Question: Express in one sentence what the figure is showing.
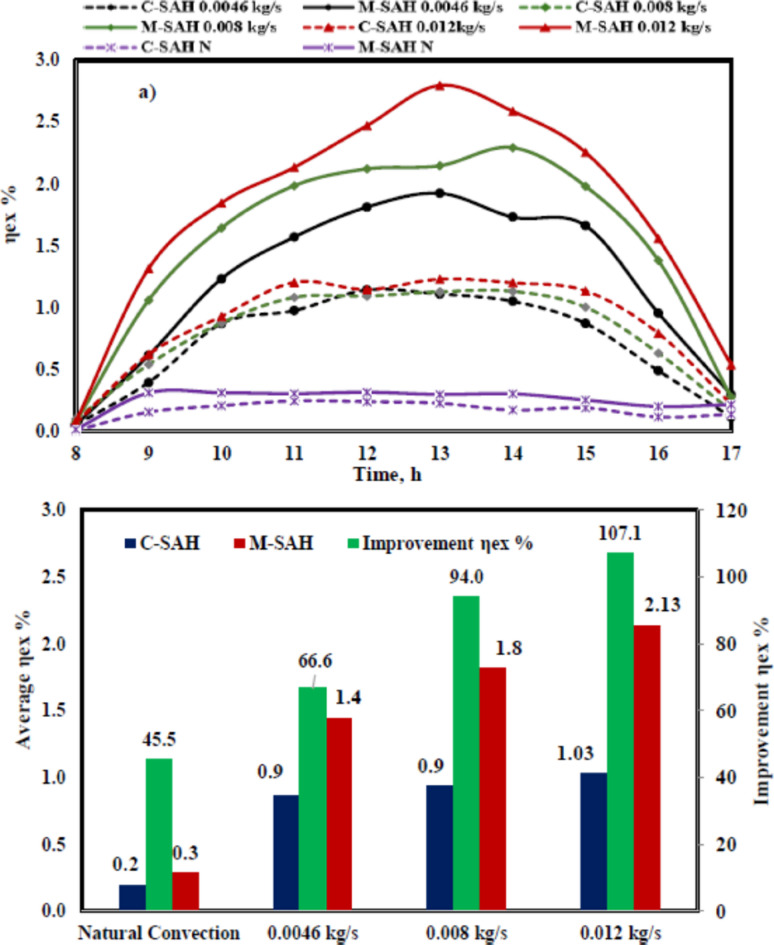
Answer: ( a ) hourly exergy efficiency comparison and ( b ) average exergy efficiency and improvements compared each case with its C-SAH.